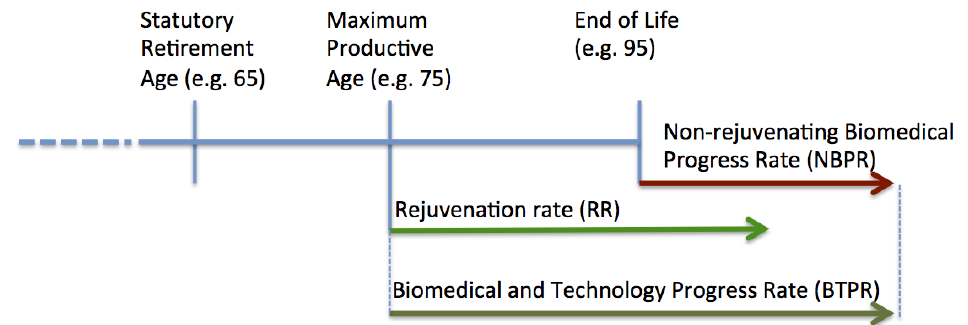
Figure 2. Rejuvenation Rate vs . Non-rejuvenating Biomedical Progress Rate. The figure depicts the hypothetical person’s lifespan, where the rate of biomedical and technology progress is comprised of the Rejuvenation Rate (RR) extending Maximum Productive Age and Non-rejuvenating Biomedical Progress Rate (NBPR) delaying the Age of Death, while not restoring the ability to do useful